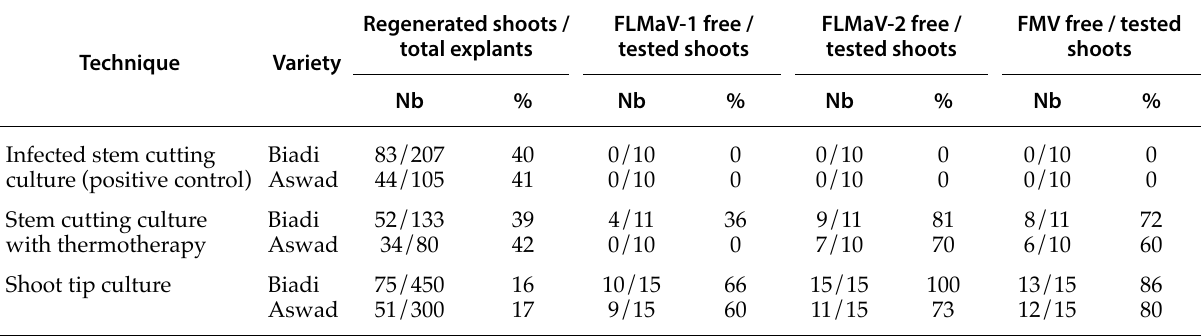
Table 1. Numbers of regenerated shoots from two Lebanese fig varieties, and numbers of virus-free explants, for explants produced after application of three different tissue culturing protocols.